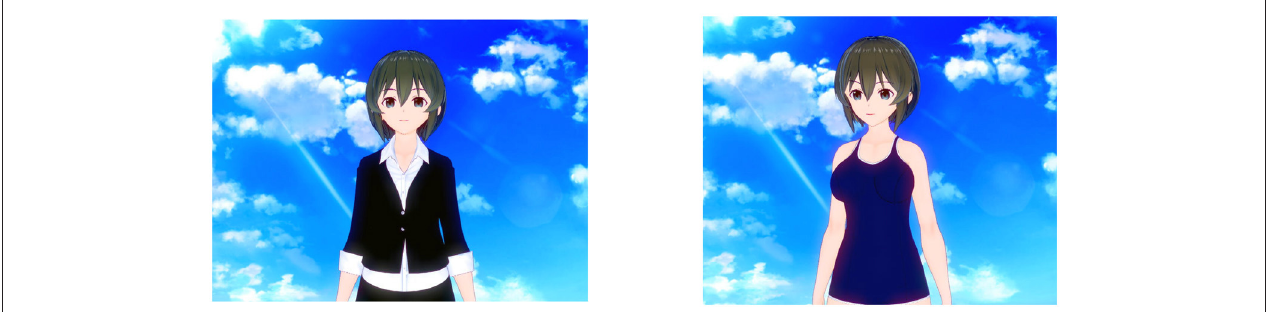
FIGURE 2 | The agent I used in the experiment. The left agent is used for business suit conditions, and the right is for swimsuit conditions. Adapted/Reproduced with permission from IVR, available at https://vkatsu.jp/.